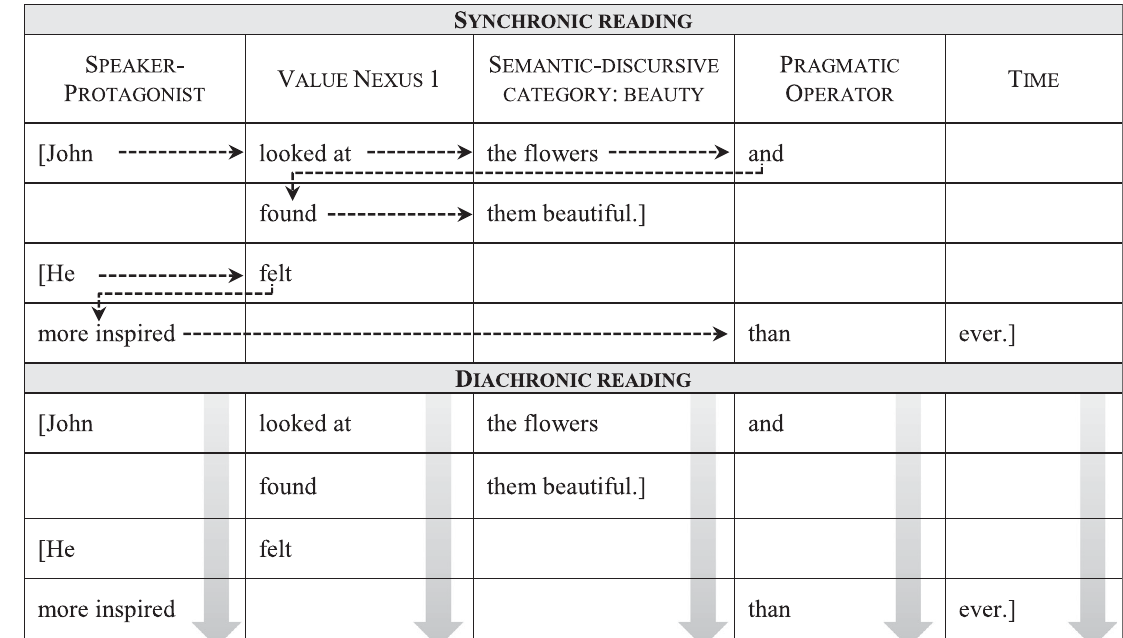
TABLE 1 | The two readings in the synchronic-diachronic